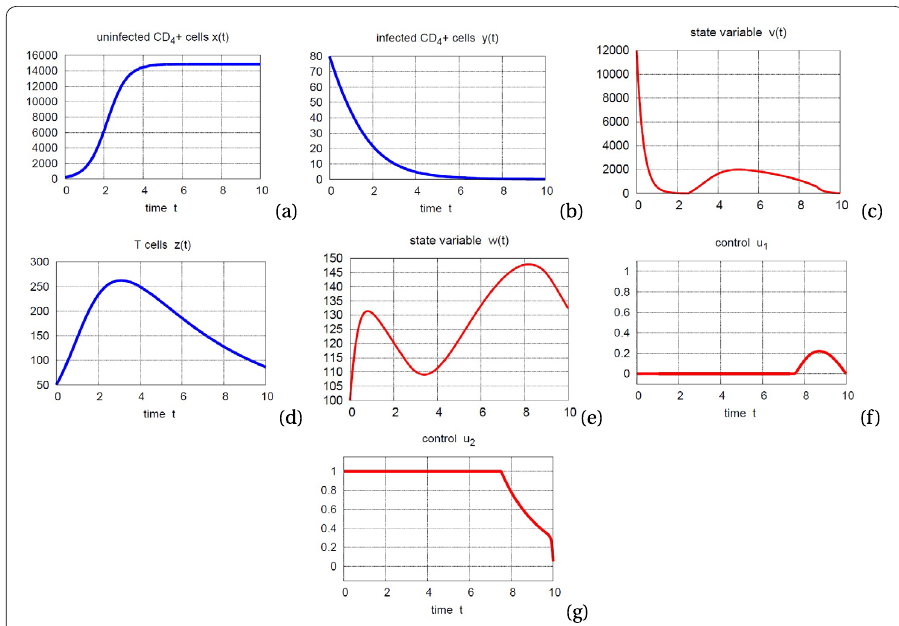
Figure 1 ( a ) Saturation level of uninfected CD + 4 T-cells with optimal control for Column 3 of Table 2 ( b ) Level of infected CD + 4 T-cells with optimal control for Column 3 of Table 2 ( c ) level of viral load with optimal control for Column 3 of Table 2 ( d ) level of T-cells with optimal control for Column 3 of Table 2 ( e ) level of B-cells with optimal control for Column 3 of Table 2 ( f ) Behavior of optimal control, u ∗ 1 as protease inhibitor for Column 3 of Table 2 ( g ) Behavior of optimal control, u ∗ 2 as reverse transcriptase inhibitor for Column 3 of Table 2